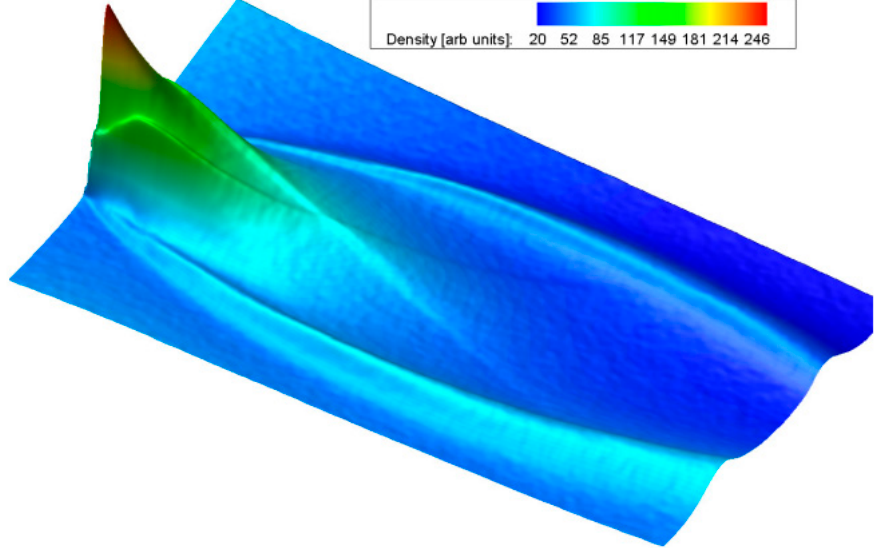
Figure 35. Theoretical/experimental data comparison for the rainbow Schlieren. Reprinted with permission from Ref. [46] (2017).